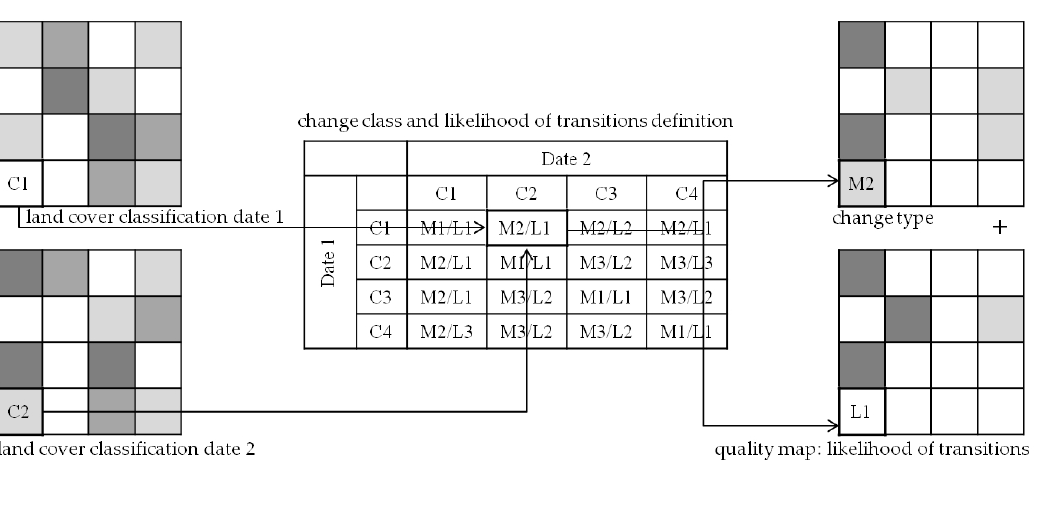
Figure 7. Change determination. In which Ck, Ma and Lb are respectively the land cover class k, the collapsed change class a and the likelihood b of the